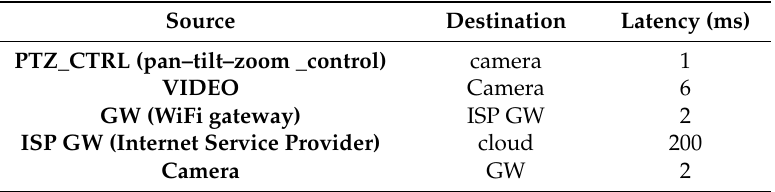
Table 4. Description of network links.